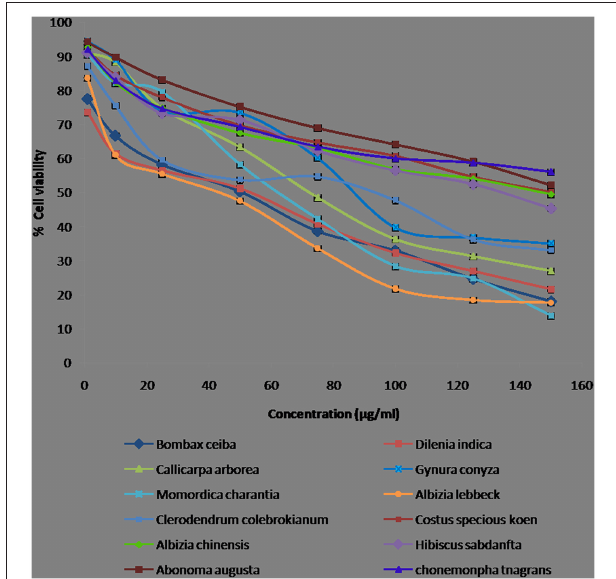
FIGURE 2 | Cell proliferation percent inhibition of methanolic leaf extracts from Mizoram on human hepatocarcinoma cell line (HepG2). Values are presented as mean ± SEM and are significant at p <